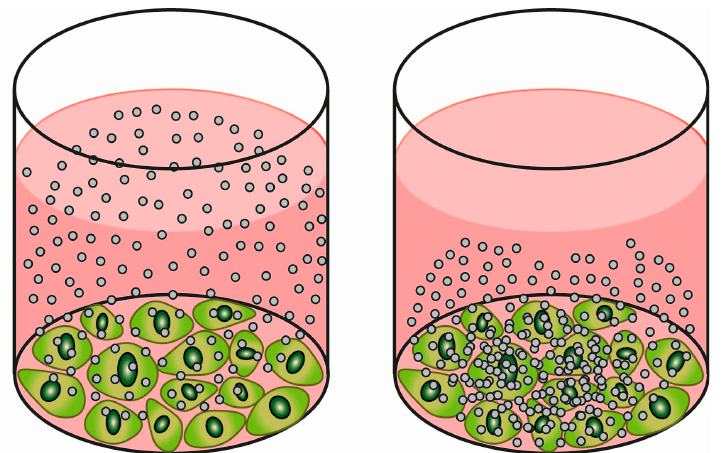
Figure 3. Visual representation of two NMs with different properties, resulting in different doses delivered to the cells, when administered doses are equal. delivered to the cells, when administered doses are